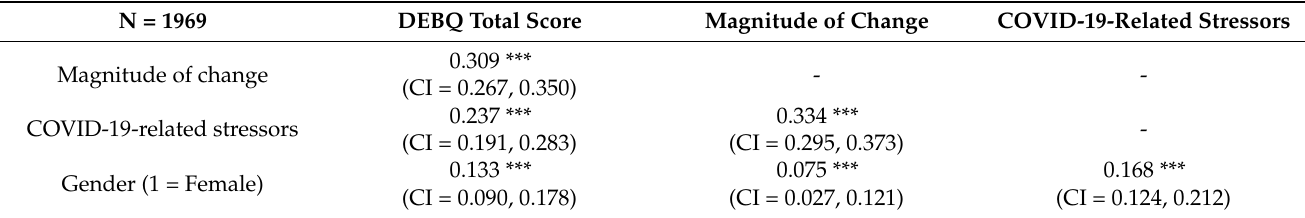
Table 6. Pearson’s correlations between the study’s main